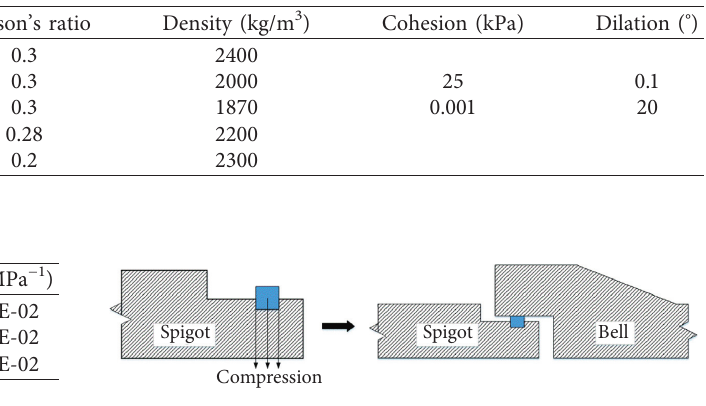
Figure 5: Assembly of the gasketed bell-and-spigot joint.